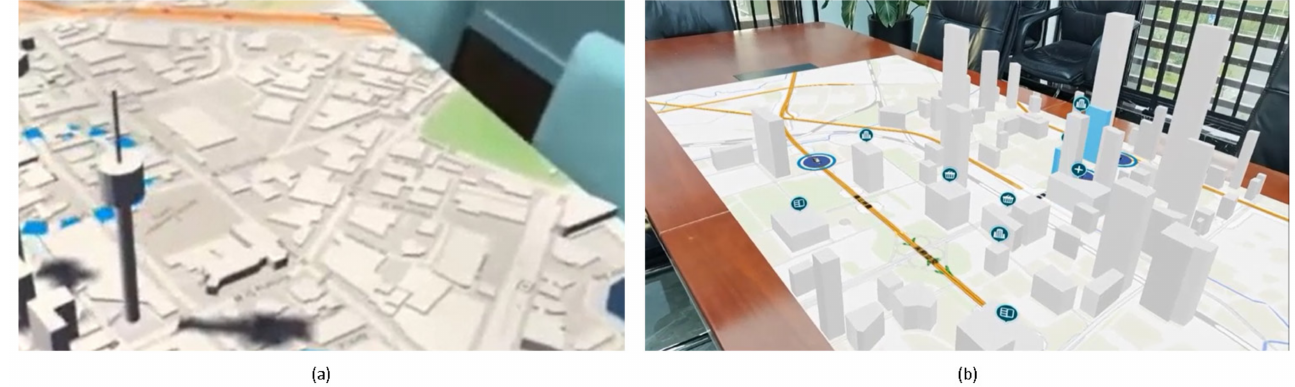
Figure 8. Two methods of vector data visualization for real world enhancement: ( a ) Mapbox, ( b ) the proposed